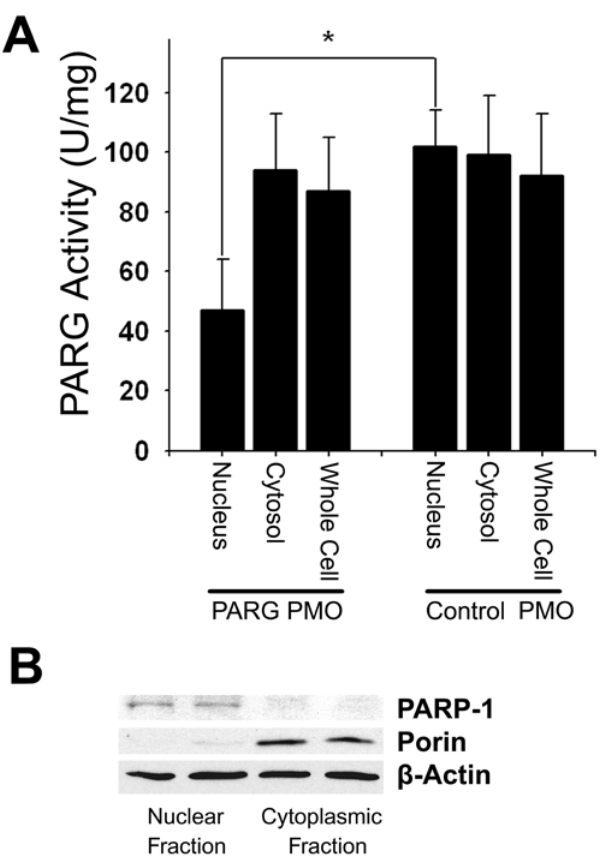
Figure 2. Nuclear PARG activity is selectively reduced by PARG antisense PMO. ( A ) Activity assays of whole-cell, nuclear, and cytoplasmic cell fractions. n=5; * p , 0.05. ( B ) Western blots of cell fractions showed the nuclear marker PARP-1 confined to the nuclear fraction and the mitochondrial marker porin confined to the cytoplasmic fraction. The two lanes show samples prepared from different culture plates. Blots are representative of 3 independent